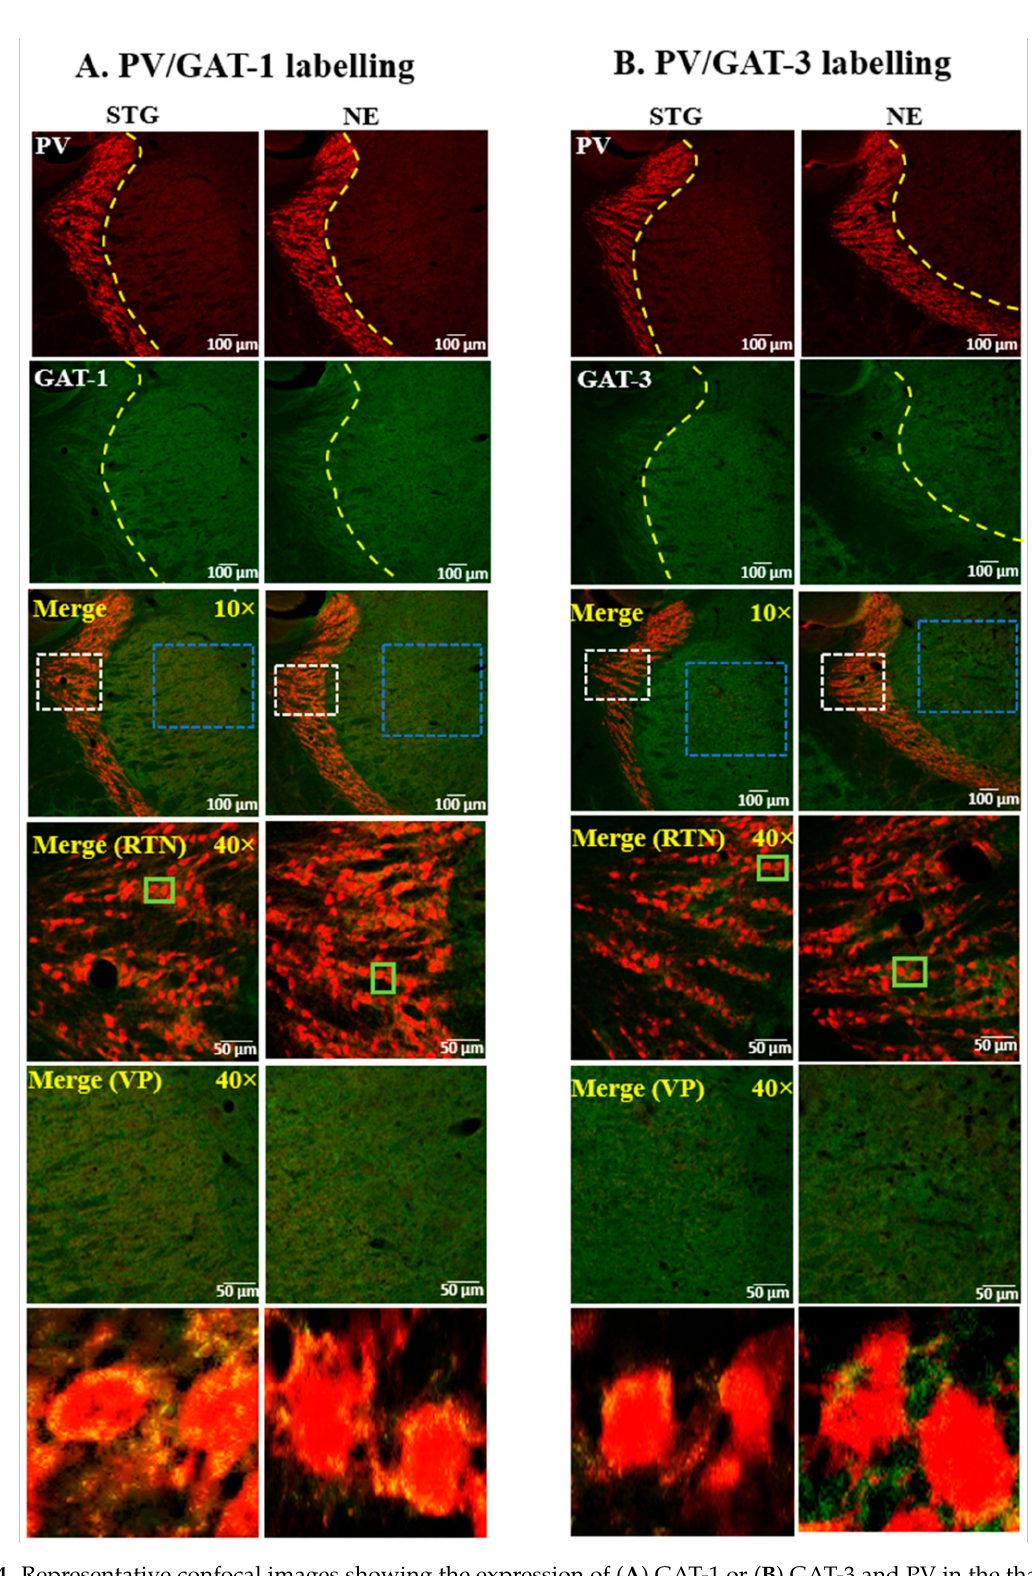
Figure 4. Representative confocal images showing the expression of ( A ) GAT-1 or ( B ) GAT-3 and PV in the thalamus of epileptic stargazers (STG) and non-epileptic littermates (NE). Merged images at low magnification (10 × ) and medium magnification (40 × ) are shown. White and blue dotted boxes in the merged images were magnified in the fourth and fifth panel, respectively. Green boxes in the fourth panel were magnified in the bottom panels of figures ( A , B ) to show punctate